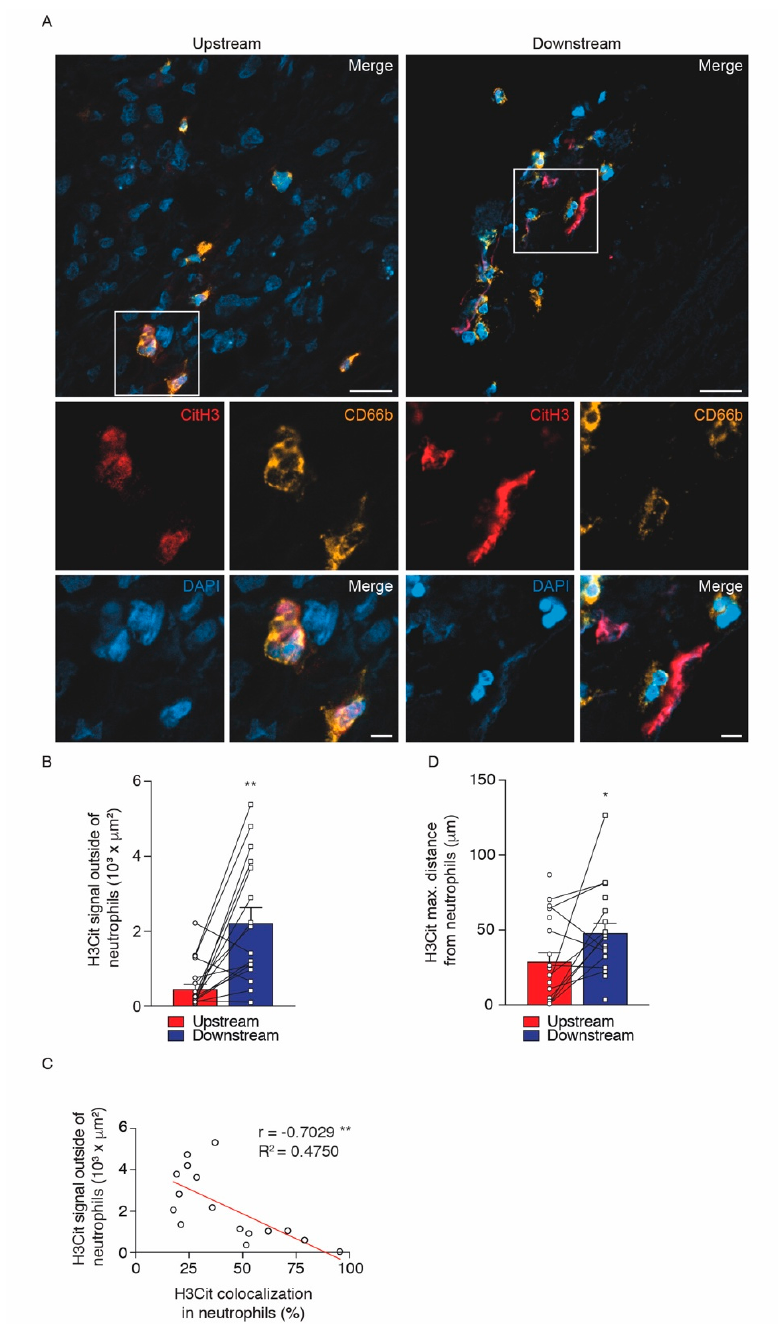
Figure 4. Pattern of Citrullinated histone-3 (H3Cit) signal distribution in upstream versus downstream the blood flow plaque regions of human carotid artery. ( A ) Representative microphotographs of immunofluorescence signal of H3Cit outside of the neutrophil cells on upstream (left panels) and downstream (right panels) plaque regions of human carotid artery. ( B ) Quantification representing bar graph average of H3Cit signal outside the neutrophils and ( C ) Spearman’s rank correlation coe ffi cients between H3Cit signal outside of neutrophils and H3Cit colocalization in neutrophils. ( D ) Maximum distance of H3Cit signal from neutrophil cells in upstream and downstream plaque to the blood flow regions. Vortex distance analysis from immunofluorescence images was quantified in Imaris software and expressed as mean ± SEM. Scale bar for A: 20 µ m (top panels) and white frames in A represent area selection for larger magnification images of 5 µ m (bottom panels). n = 16 patients for each atherosclerotic region. ** p < 0.01 and * p < 0.05 Wilcoxon Matched Pairs